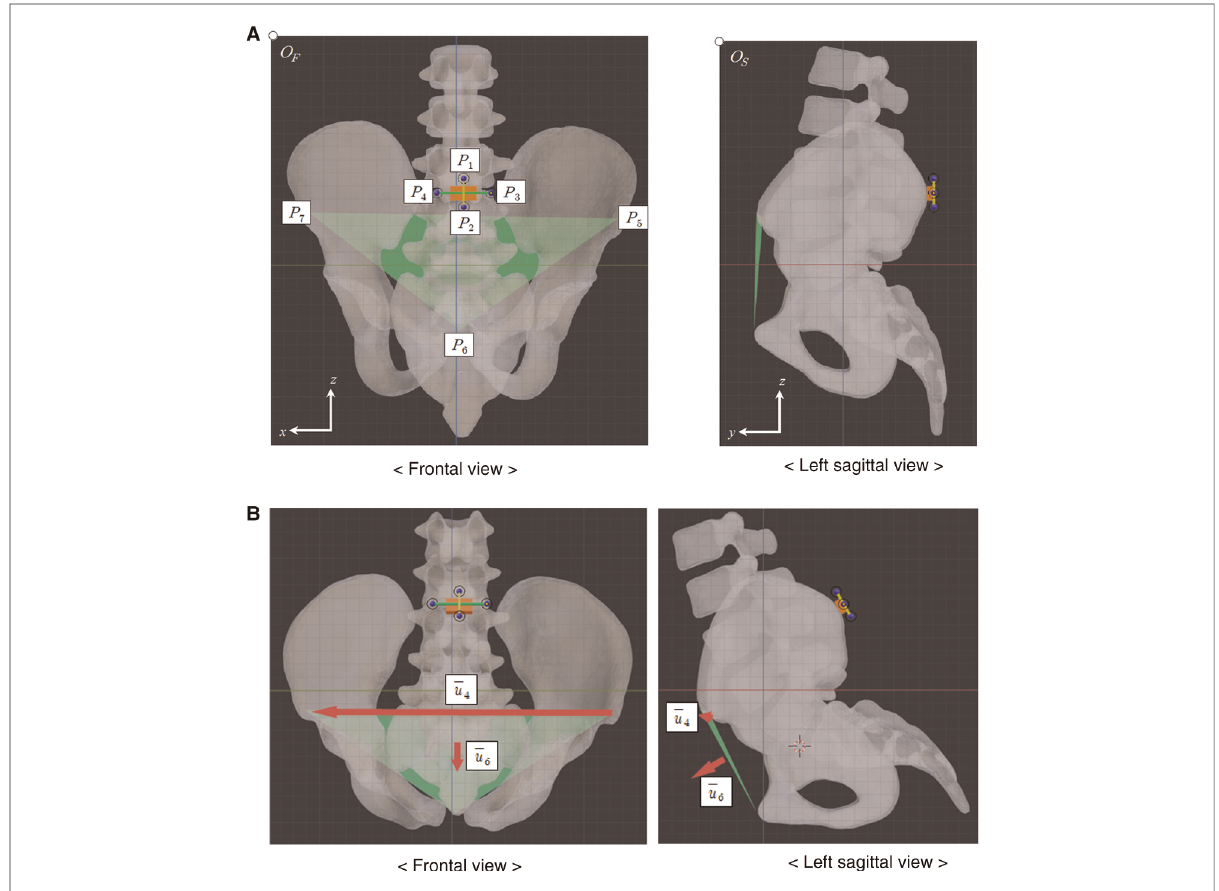
FIGURE 1 Frontal and left sagittal images of pelvic model, including the IMU sensor and the APP. ( A ) Neutral standing posture. ( B ) Flexion 30° posture.